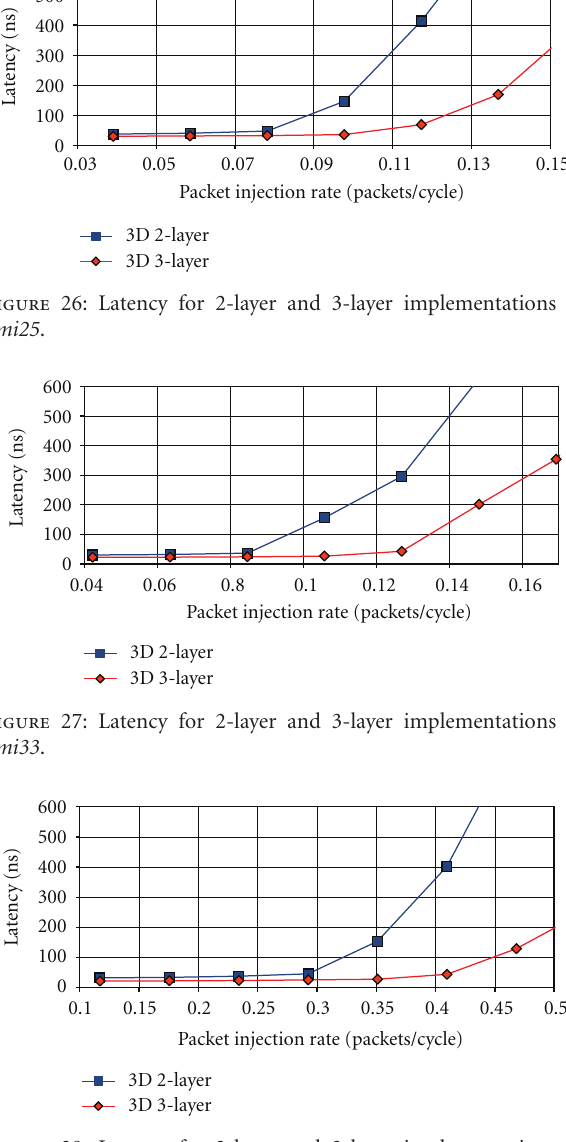
Figure 28: Latency for 2-layer and 3-layer implementations of ami49